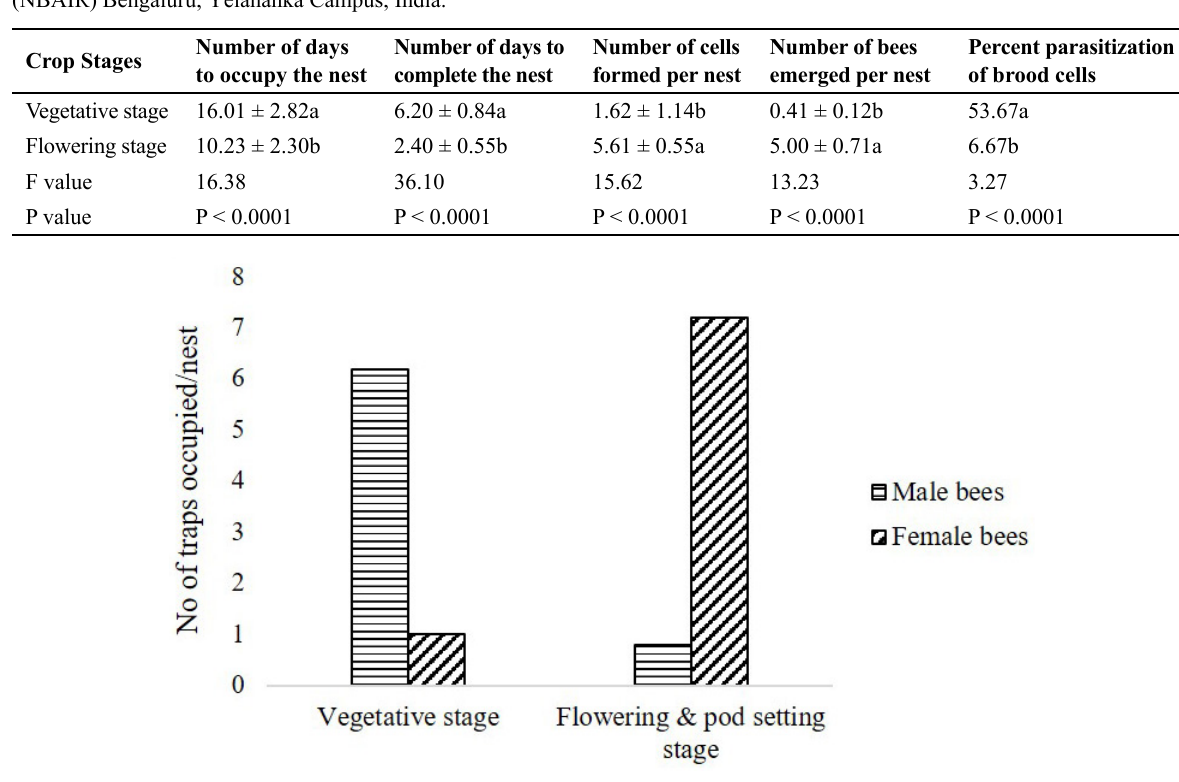
Table 2. Nest development parameters of leafcutter bees Megachile Latreille, 1802 at two different crop stages of Pigeon pea ( Cajanus cajan (L.) Millsp., Fabaceae) in the experimental farm of ICAR-National Bureau of Agricultural Insect Resources (NBAIR) Bengaluru, Yelahanka Campus,